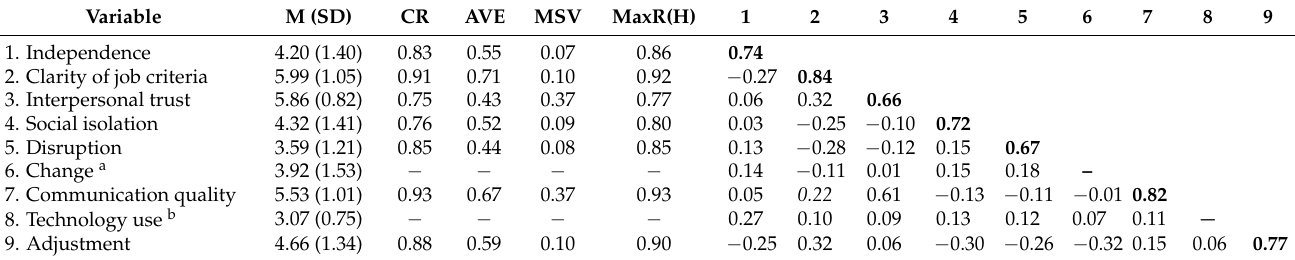
Table 2. Correlation Matrix of variables with validity